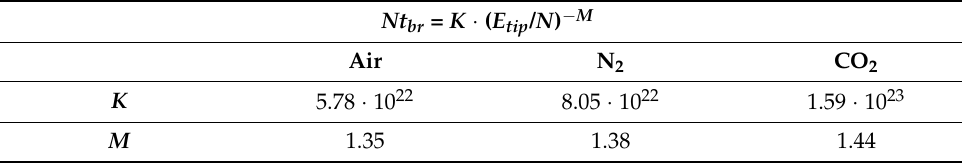
Table 3. Fitting parameters K and M for Equation (7) in air, N 2 and CO 2